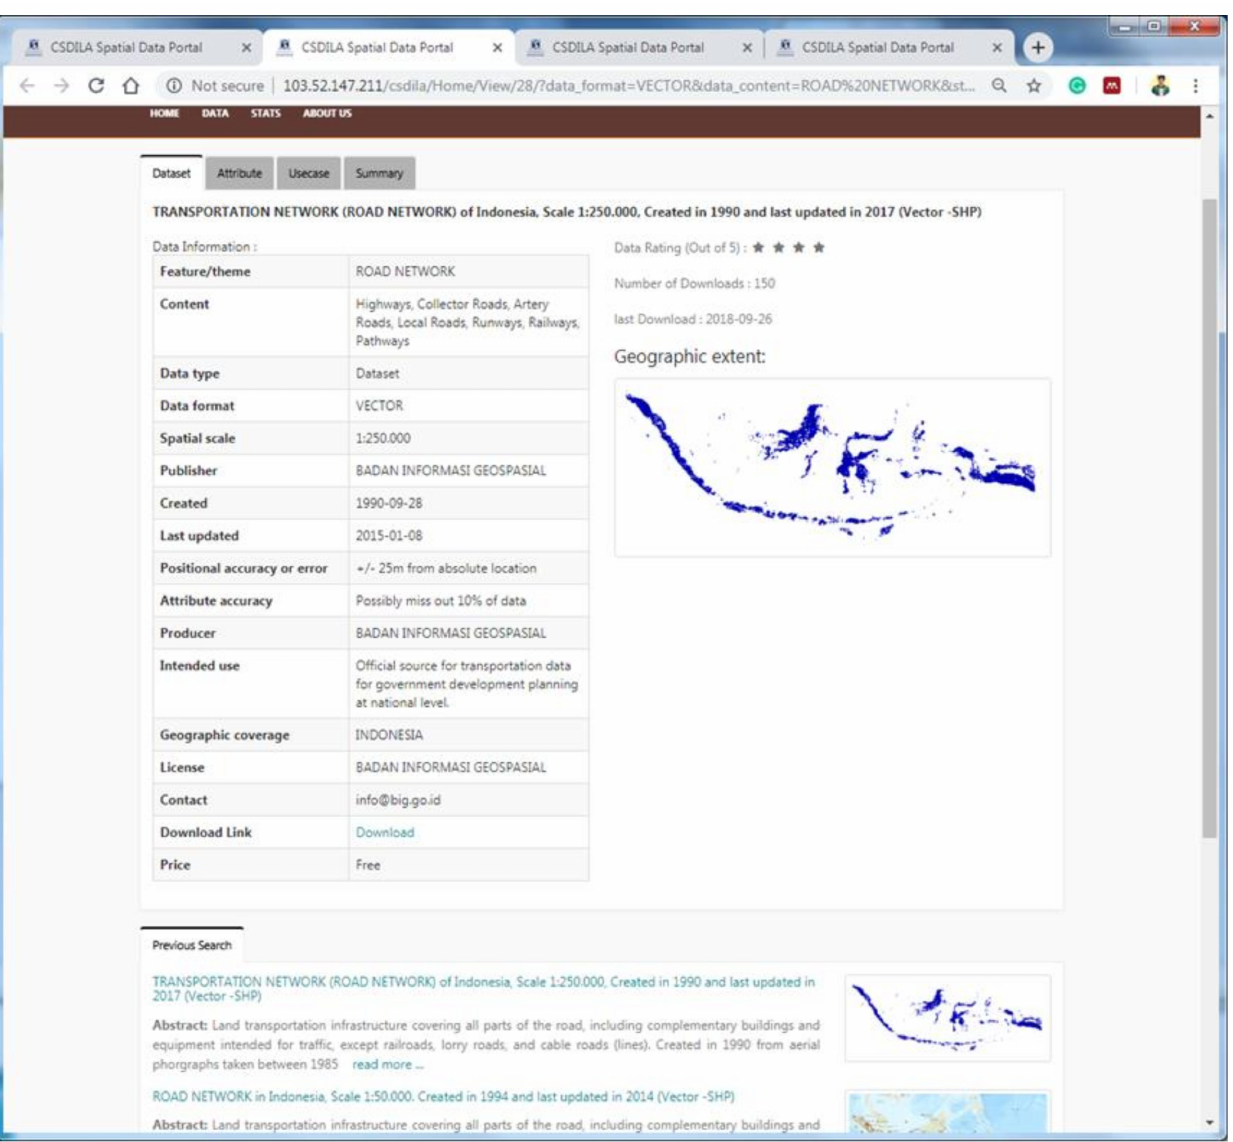
Figure 6. Metadata page (Dataset